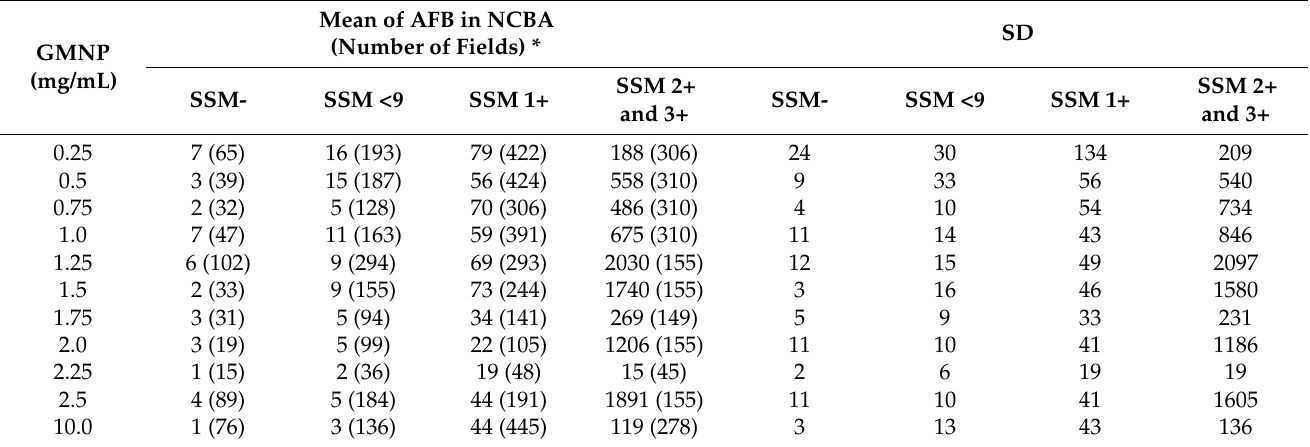
Table 4. Differences in the number of AFB obtained per field in SSM and NCBA at different GMNP concentrations in sputum sample aliquots from people with pulmonary tuberculosis, according to IUATLD classification [5,6].